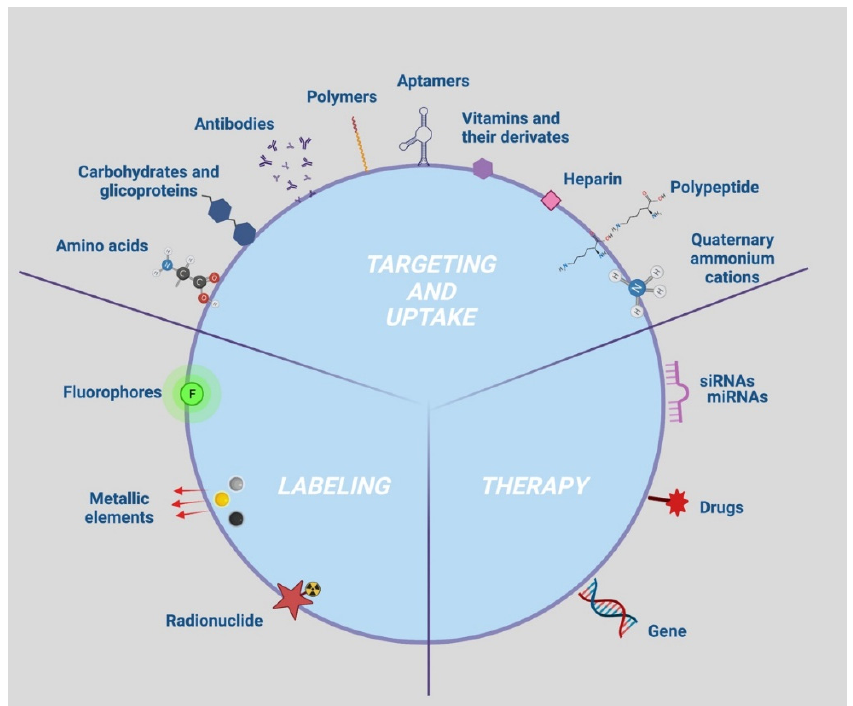
Figure 4. Multimodal NP surface modifications applied for enhancing targeting, uptake, tracking, and therapy. Identification of different elements useful to improve labeling, targeting, therapy and cellular uptake. Figure created with BioRender. Available online: https://biorender.com/ (accessed on 25 March 2022).